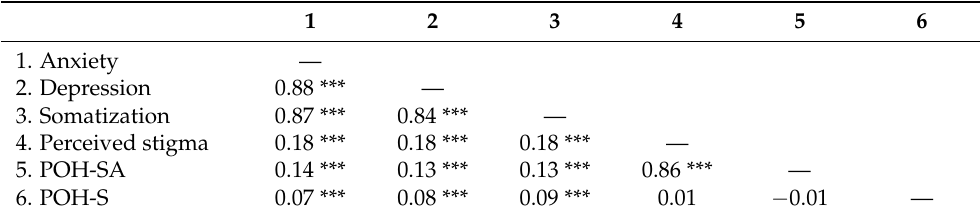
Table 2. Zero-order correlational matrix.